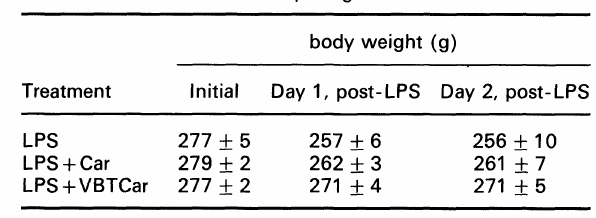
Table 5. The variation of liver lipogenesis in vivo